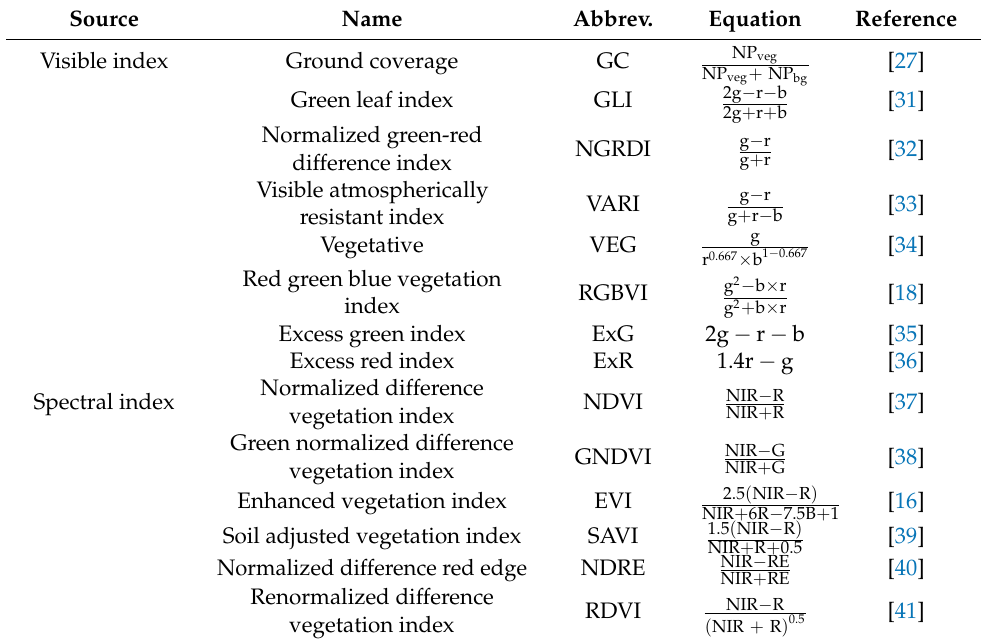
Table 1. Vegetation indexes derived from visible and multi-spectral ortho-mosaics. R, G, B, RE, and NIR are red, green, blue, near-infrared, and red edge bands, respectively. r, g, and b are normalized red, green, and blue bands of visible ortho-mosaic, respectively. NP veg and NP bg are the number of pixels in vegetation and background classes in each plot, respectively.